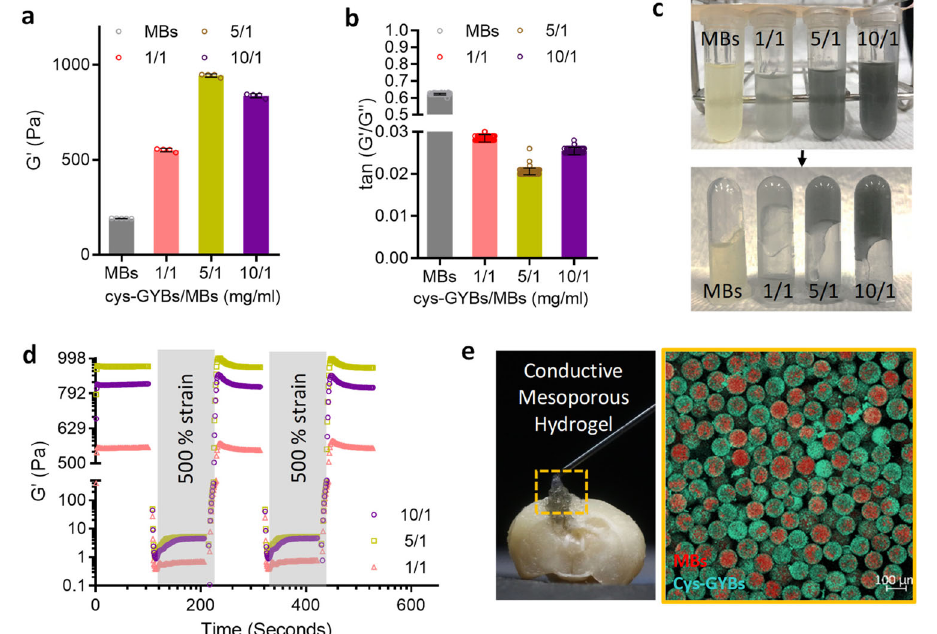
Fig. 3 | Rheologicalcharacterization ofself-healing behaviorofCMH. a Storage (G ′ )modulusand( b )tan(G ” /G ’ )ofCMHasafunctionofcys-GYBs-to-MBsratio(mg/ ml). Error bars represent mean ± s.d., n = 5. c The gelation of CMH at various cys- e CMH was modulable to macroscale shapes in a TBI